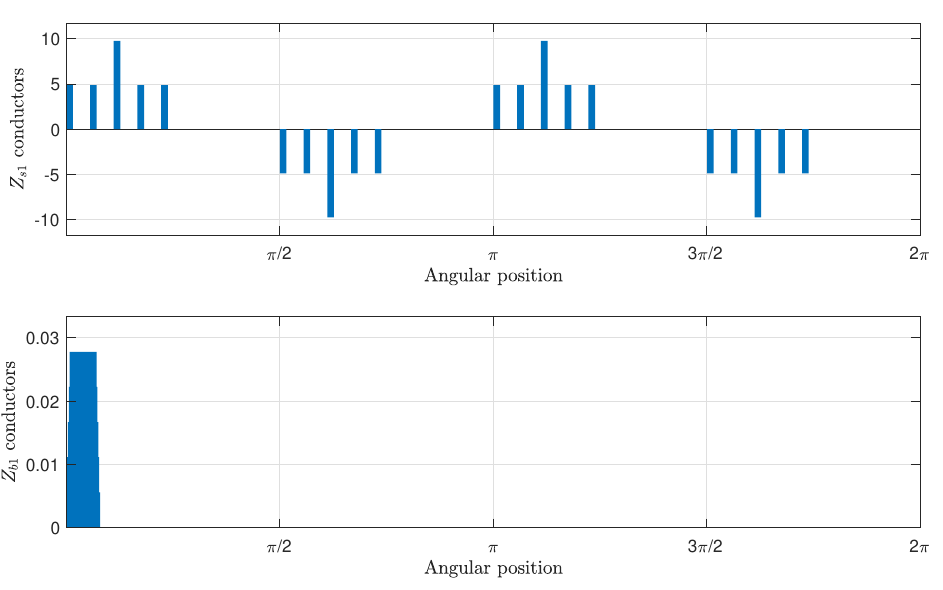
Figure 14. Conductors per air gap interval of a stator winding ( top ) and a rotor bar ( bottom